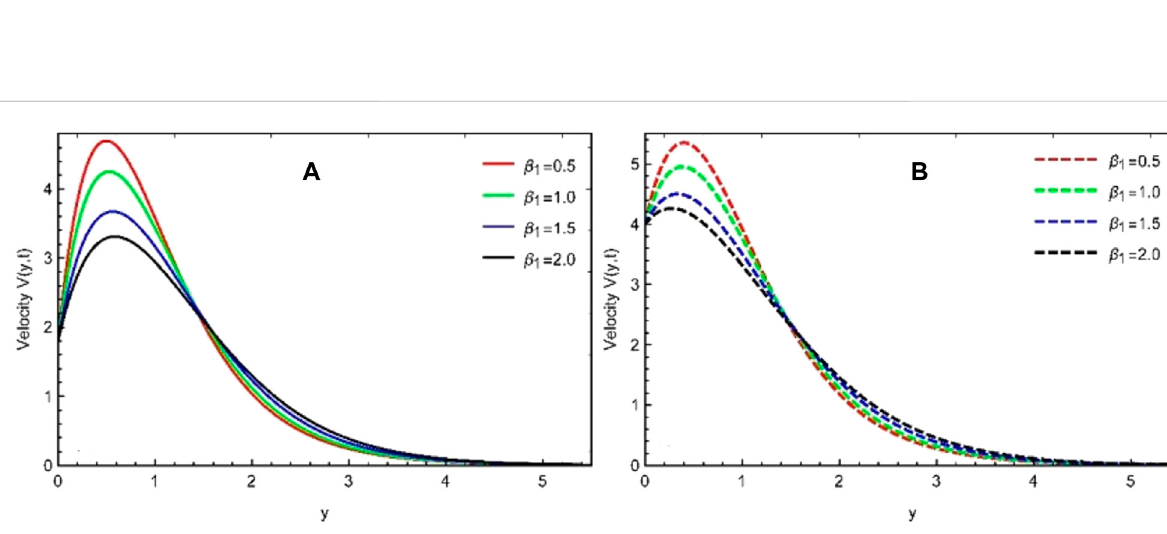
FIGURE 8 Velocity plot for β 1 with α (cid:3) β (cid:3) γ (cid:3) 0 . 8 , Pr (cid:3) 11 . 4 , Gr (cid:3) 8 . 0 , ( a ) : t (cid:3) 2 . 0 ; and ( b ) : t (cid:3) 4.